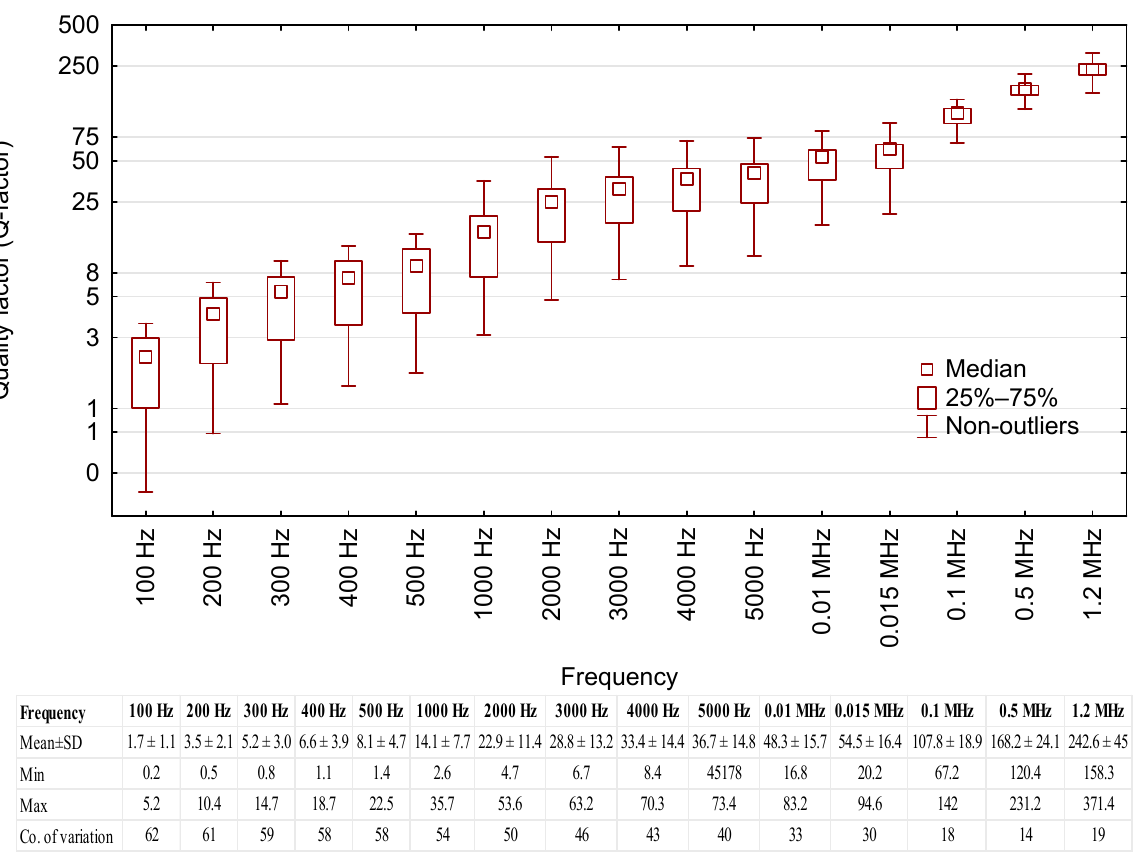
Figure 7. The quality factor of merit readings for the tested oil samples, including base data for the results.